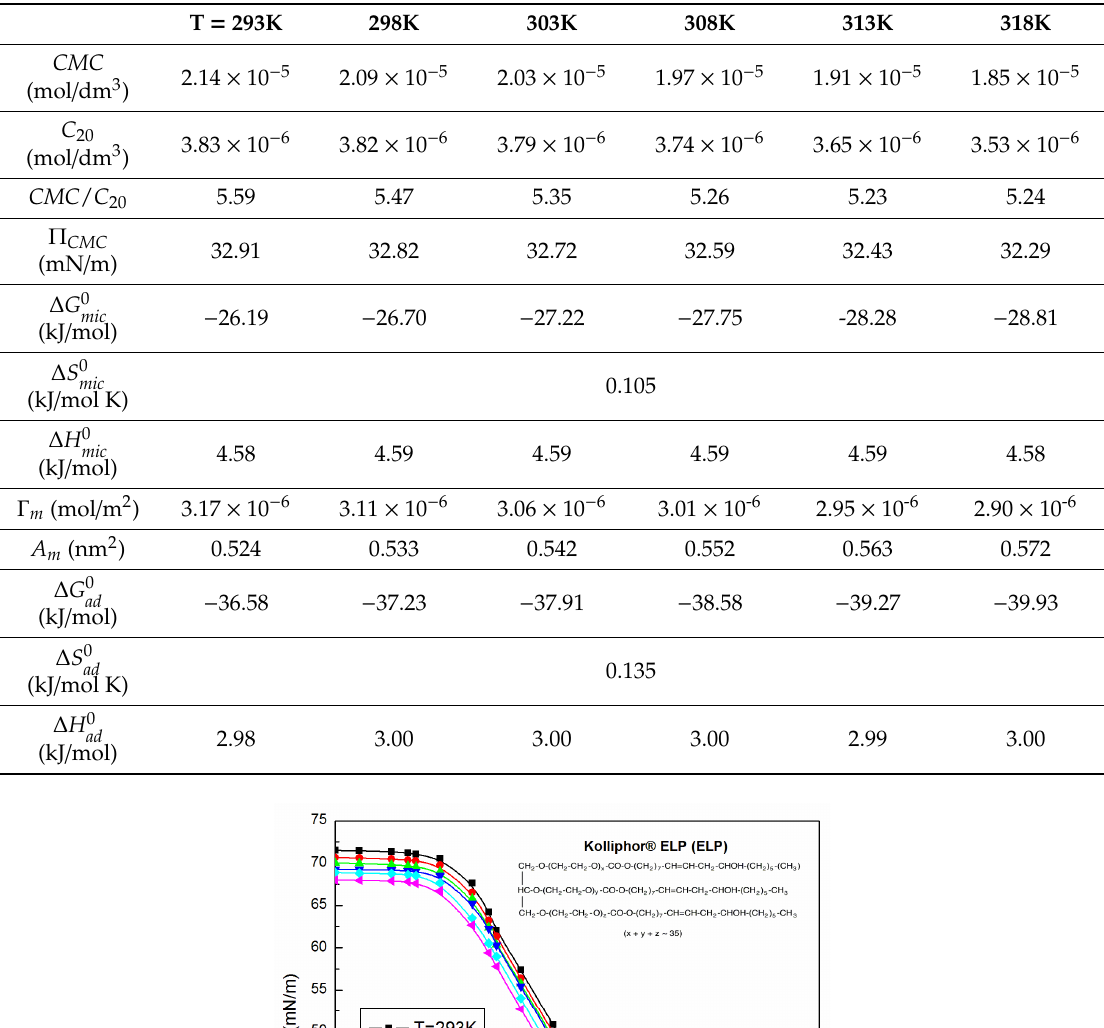
Table 1. Values of CMC , C 20 , CMC / C 20 , Π CMC , ∆ G 0 the aqueous solutions of ELP at the temperatures from 293 to 318 K.